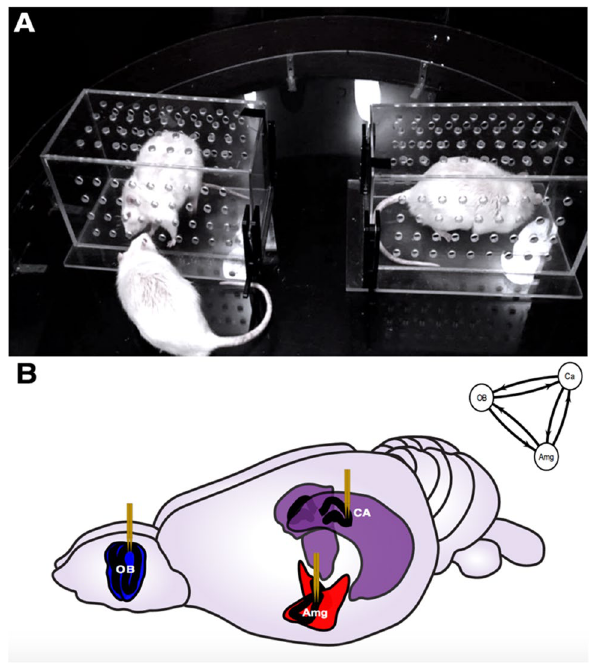
Figure 4. Neural experimental setup. ( A ) Two rats were placed in separate Plexiglas enclosures, while an implanted rat on the outside was free to roam the field and sniff through the holes in those enclosures. The implanted rats were presented with both a novel and a familiar rat. The implanted rat freely roams the field and investigates either the novel or familiar rat. Rats were removed from the field 2 min and 30 s after the onset of a trial. Trials were counterbalanced to control for place preferences, so novel and familiar rats were presented on alternating sides of the field with each trial (See SI for more info on Social Interaction Task and Animals and Housing). ( B ) Rats were surgically implanted with electrodes for electrophysiological recordings in the main olfactory bulb (OB), hippocampus (CA) and medial amygdala (Amg) (See SI for more details on Surgery and Neural Recordings). Figure adapted from scidraw.io under Creative Commons 4.0 license 16